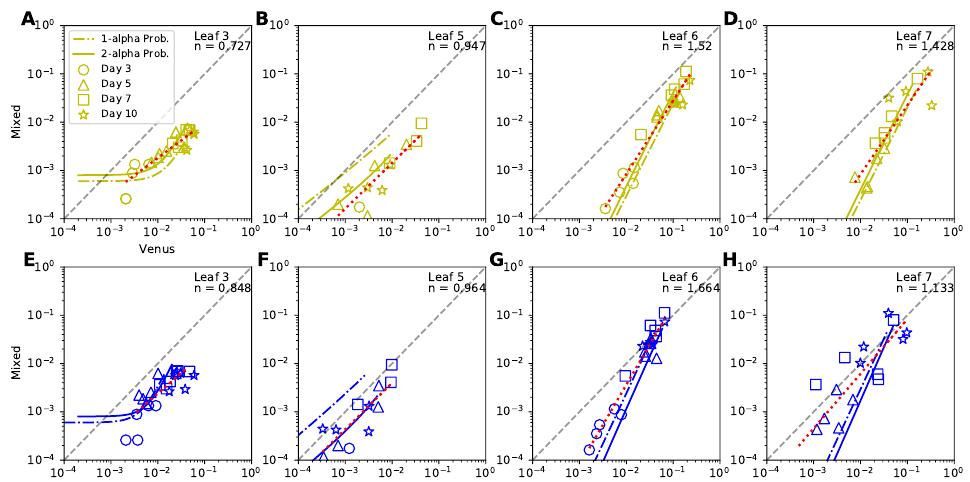
Figure 7. The two-alpha probabilistic model accurately describes the relationship between frequency of coinfected cells and those infected with a single virus for most data. We plot the relationship between frequency of cells coinfected with Venus and BFP strains of TEV and the frequency of cells infected with a single strain (( A – D ) for Venus and ( E – H ) for BFP) for various leaves of the plant (different panels) and different days since infection (shown by markers). Some of the data are not shown on a log-log plot due to zeros of the number of infected or coinfected cells. Solid lines are the predictions of 2-alpha probabilistic model (Equation (25)) and dash-dotted lines are the predictions of 1-alpha probabilistic model (Equation (24)). The red dotted lines are power functions fitted to the data. The exponents n of these functions are shown in the top right corners below the leaf number. Asymptotic relationship between the frequency of coinfected and single infected cells appears to become a straight line for all three models, a feature which we examine in Equations (S41)–(S48) in Supplemental information. We also provide a python-based script in which these data and model predictions can be explored further (Supplemental Figure